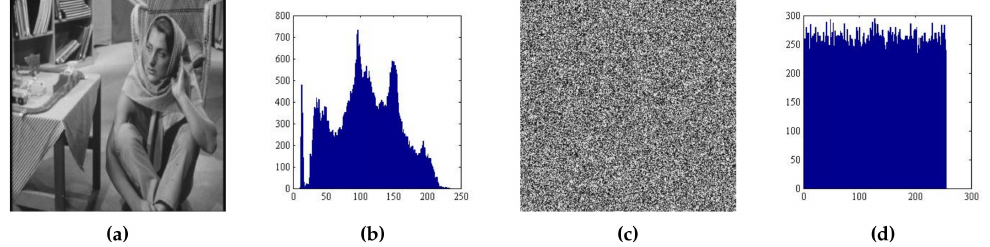
Figure 12. Result of Barbara image. ( a ) Barbara image, ( b ) histogram of Barbara image, ( c ) encrypted Barbara, and ( d ) histogram of encrypted Barbara.